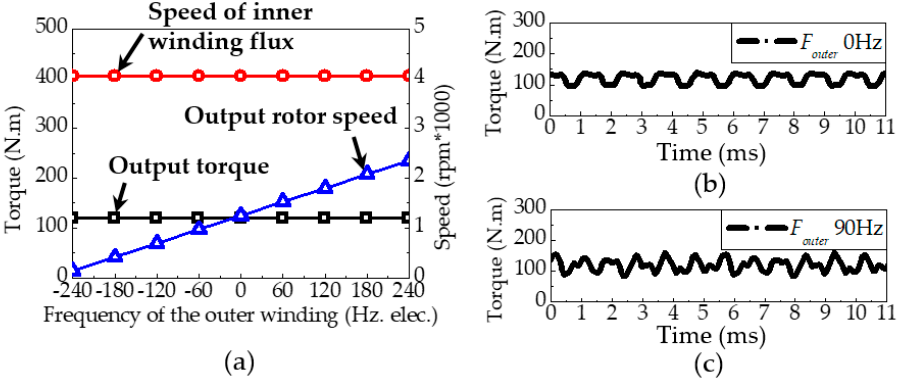
Figure 5. Operating characteristics of DFMGM: ( a ) Performance according to the variation of the frequency of the outer winding; ( b ) Instantaneous torque with time when the outer winding operates at 0 Hz (DC operation); ( c ) Instantaneous torque with time when the outer winding operates at 90 Hz.